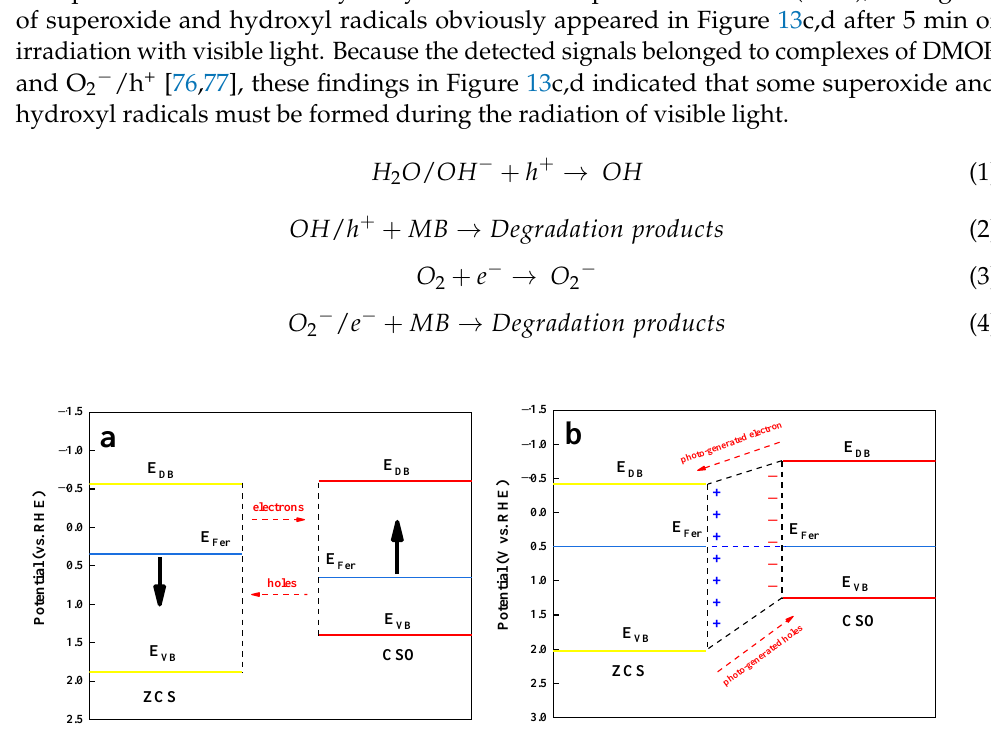
Figure 12. The band gap structure of original ZCS and CSO ( a ), and a composite of ZCS and CSO ( b ).